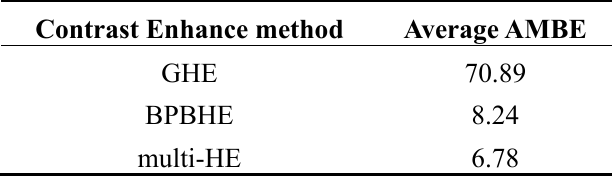
Table 2. The average AMBE values of the output